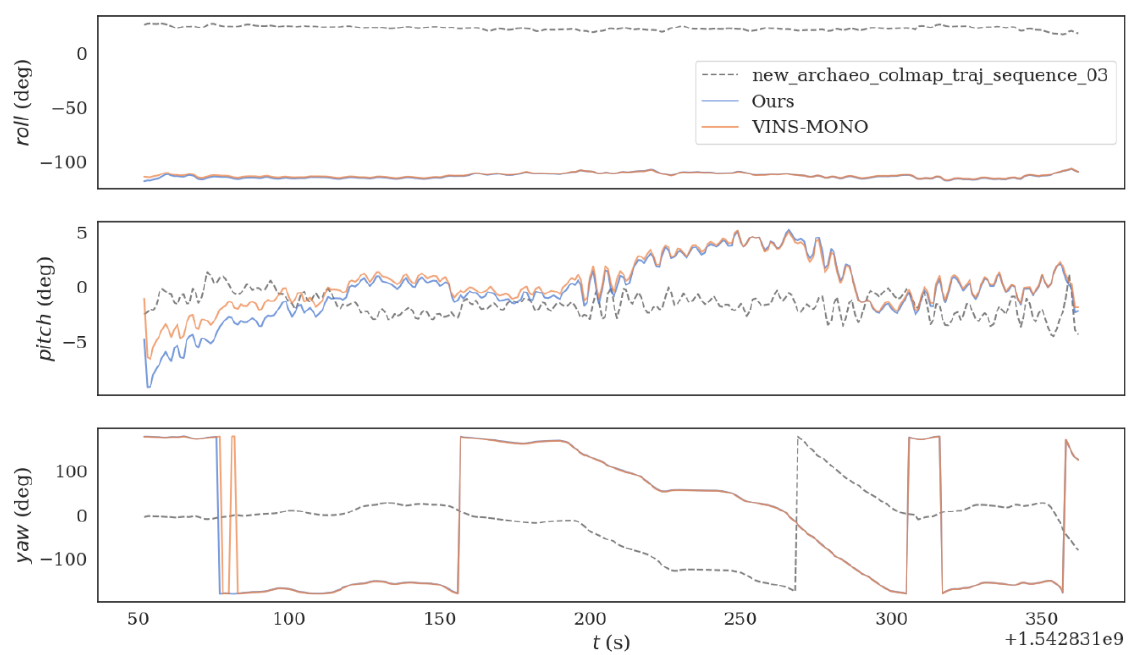
Figure 8. The figure shows the rotation error comparison between the original algorithm and the improved algorithm in sequence_03.bag